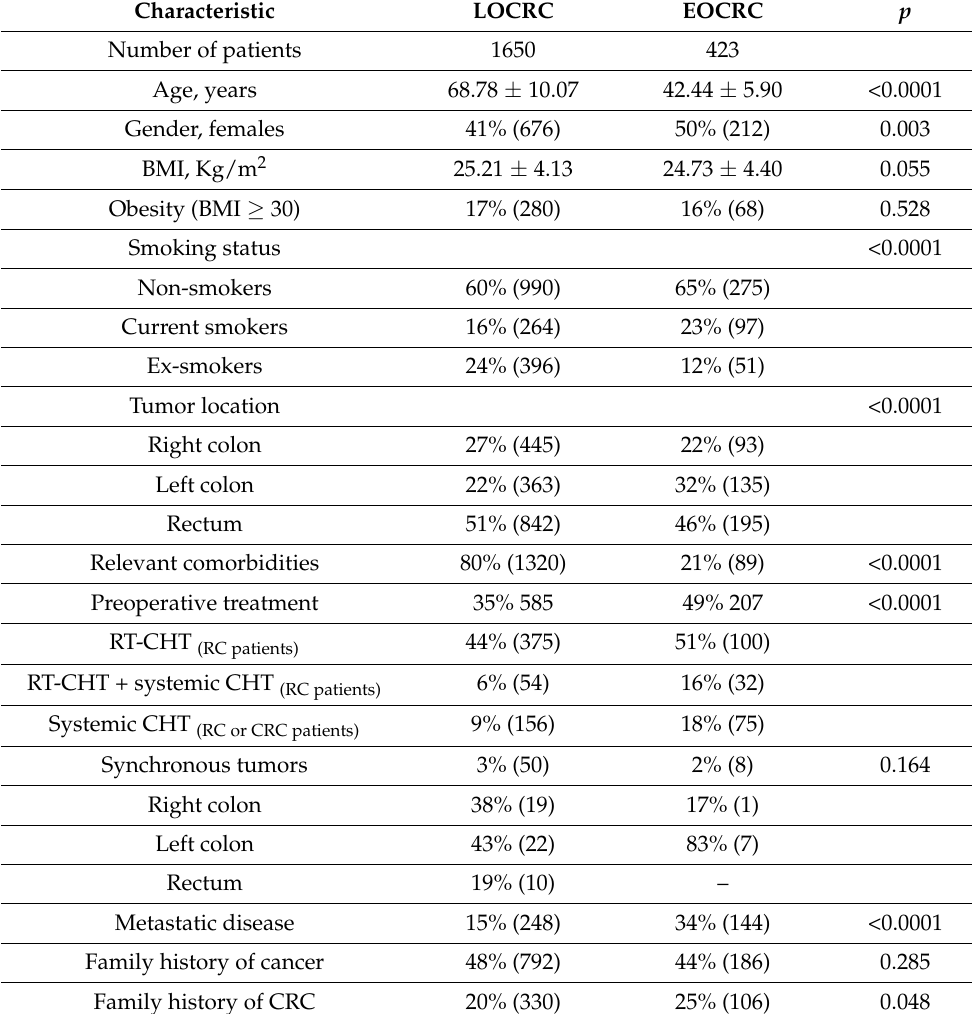
Table 1. Baseline and clinical characteristics, mean ± standard deviation, median [IQR], and %